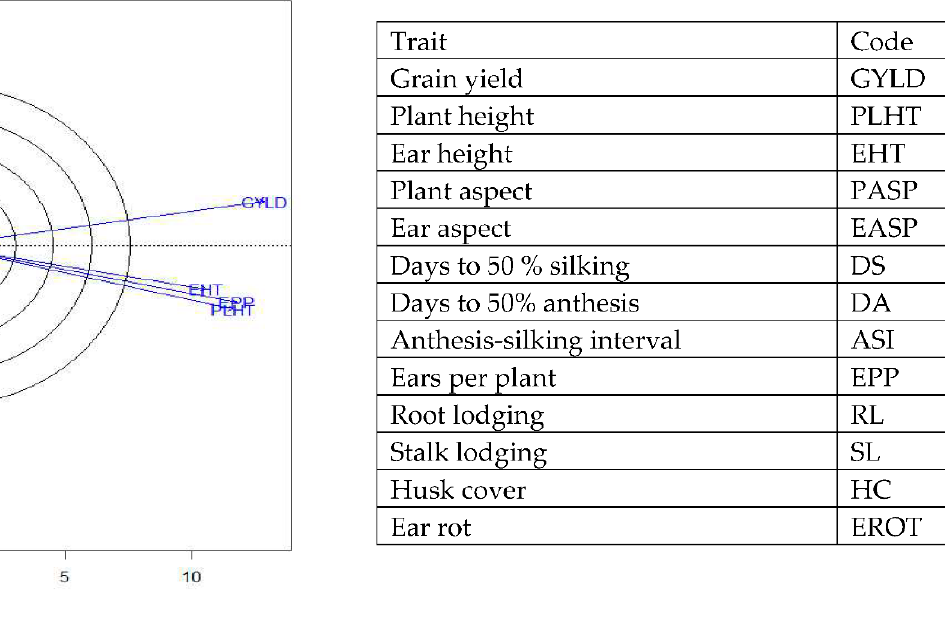
Figure 8. A vector view of the genotype-by-trait biplot showing interrelationships among all traits of 190 early maturing pro-vitamin A hybrid maize evaluated under optimal conditions at Bagauda, Kadawa, Abuja, Ikenne and Mokwa, Nigeria in 2016 and 2017. The biplot was based on genotype-focused singular value partitioning (‘SVP = 2) and is therefore appropriate for visualizing the relationships among traits. Principal component (axis 1) and axis 2 for model 2 explained 64.76% of the variation among traits.